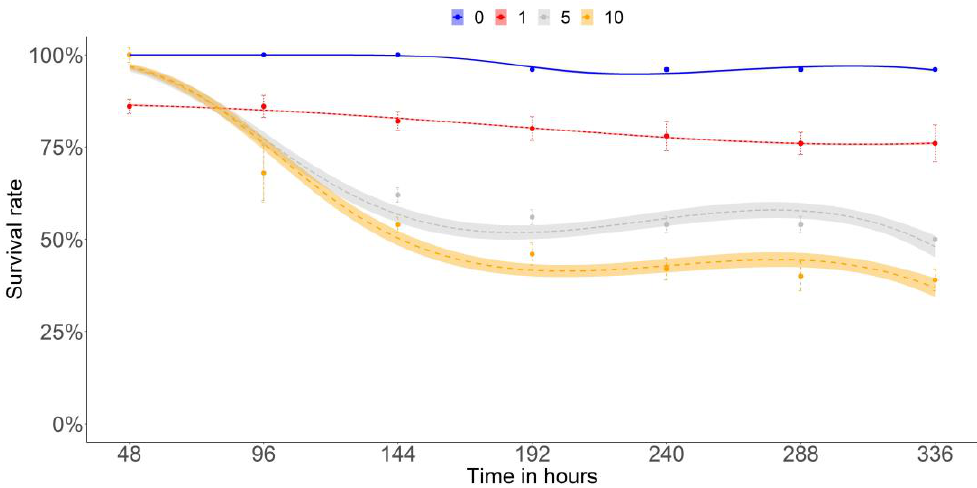
Figure 2. Larval survival every 48 h after exposure of P. xylostella larvae to botanical extracts of M. albicans at concentrations of 1%, 5%, and 10% and to the control.